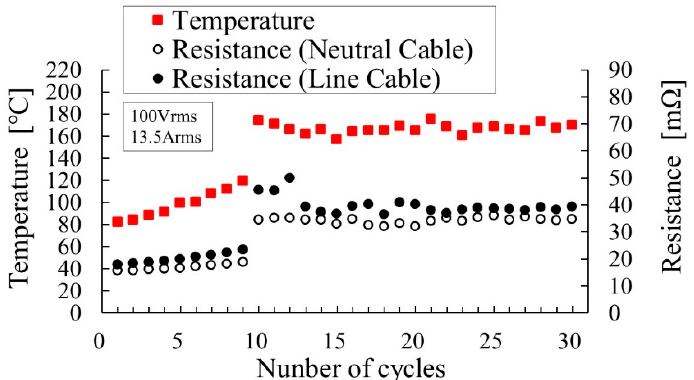
Figure 5. Temperature on the polyvinylchloride (PVC) near the partially broken part and the resistances of the cables with the partially broken element conductors.